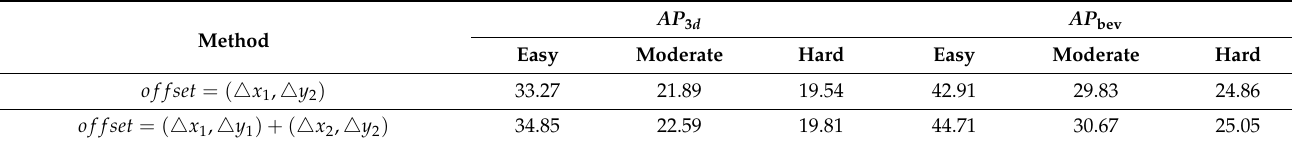
Table 6. Ablation study of offsets.